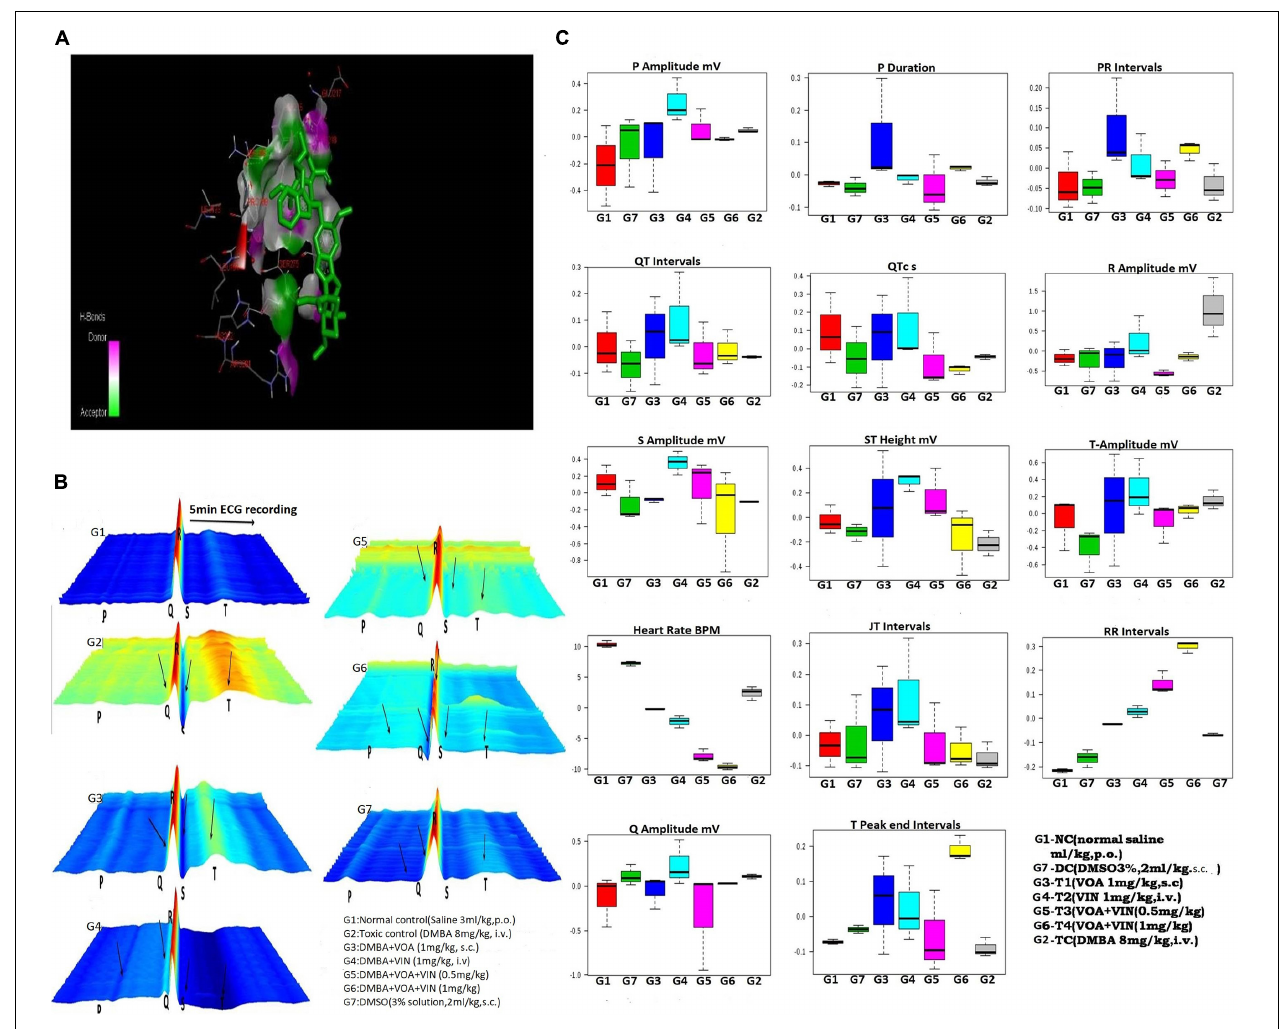
FIGURE 1 | (A) Docked pose of VOA with the PHD-2 protein. Docking of VOA with PHD-2 was performed using the Auto Dock Tools 4.2. VOA formed hydrogen bonds with LEU193, LEU191, HIS282, ARG282, ARG281, ALA190, LEU188, PHE213, GLY213, LEU214, GLU217, ASP278, SER275, SER214, LEU271, and THR218, with a binding energy of –7. (B) Waterfall map presentation of the ECG/HRV recording of experimental animals. In the figure, the deformities in the ECG are indicated by arrows. Groups are as follows: NC, normal control (saline 2 ml/kg); G2, toxic (DMBA 8 mg/kg, i.v.); G3, VOA (1 mg/kg, s.c.); G4, VIN (1 mg/kg, i.v.); G5, VOA (0.5 mg/kg) + VIN (0.5 g/kg, i.v.); G6, VOA (0.5 mg/kg) + VIN (0.5 g/kg, i.v.); and G7, DMSO (3%, s.c.). (C) Box-cum-whisker plot of the ECG/HRV recording of experimental animals. 1 (red): NC (normal saline 2 ml/kg, p.o.); 2 (green): DC (DMSO 3%, 2 ml/kg, p.o.); 3 (blue): G3 (VOA 1 mg/kg, s.c.); 4 (light green): G4